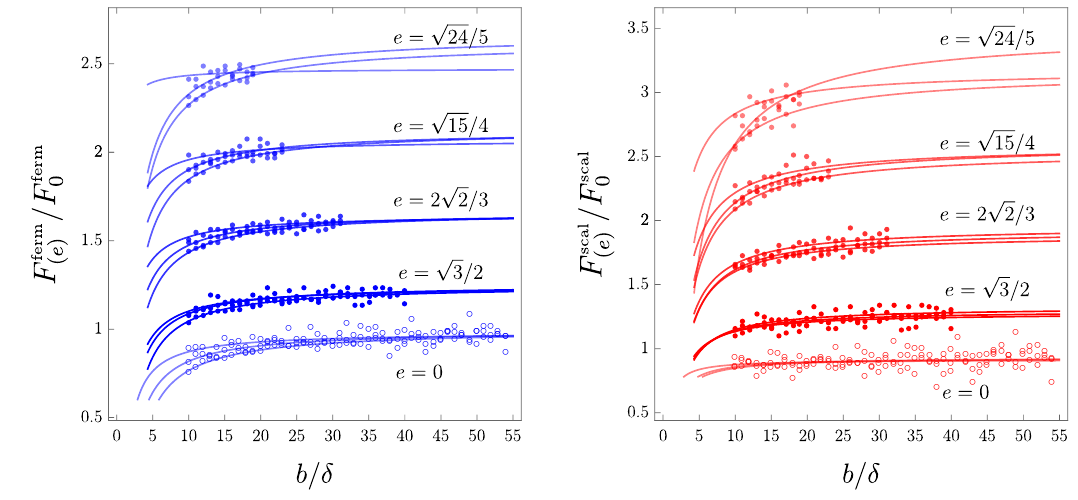
Figure 4 . We plot F normalized by the disk result for free fermions and scalars in the lattice ( e ) √ √ √ √ for eccentricities e = 0 , 3 / 2 ’ 0 . 943 , 2 2 / 3 ’ 0 . 968 , 15 / 4 ’ 0 . 968 , 2 6 / 5 ’ 0 . 98 , as a function of the ellipses’ semiminor axes divided by the lattice spacing. The data points are obtained using the constant- ε formula (3.26) for ε = 6 , 8 , 10 . The solid lines correspond to { 1 /x, 1 } fits performed — for each value of e — to the data points for fixed ε